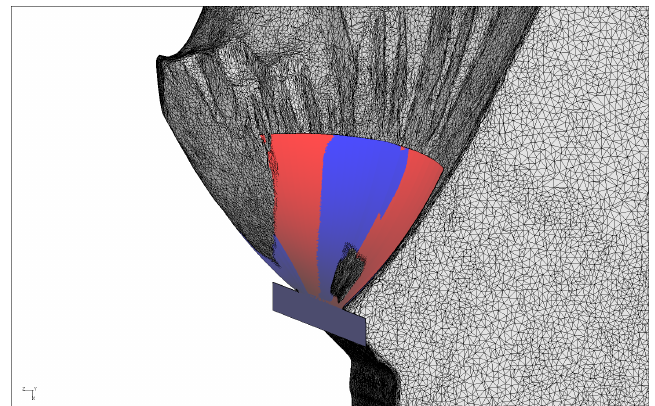
Figure 16. Specimen 1_1_00_1 experimental crack surface with the numerical prediction by the current method (in red) and the new one (in